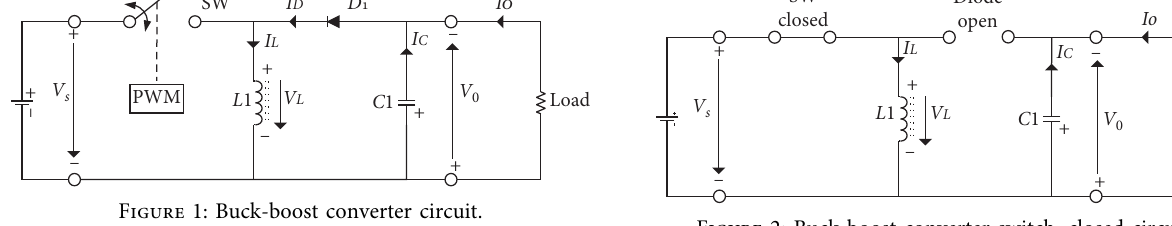
Figure 2: Buck-boost converter switch, closed circuit.